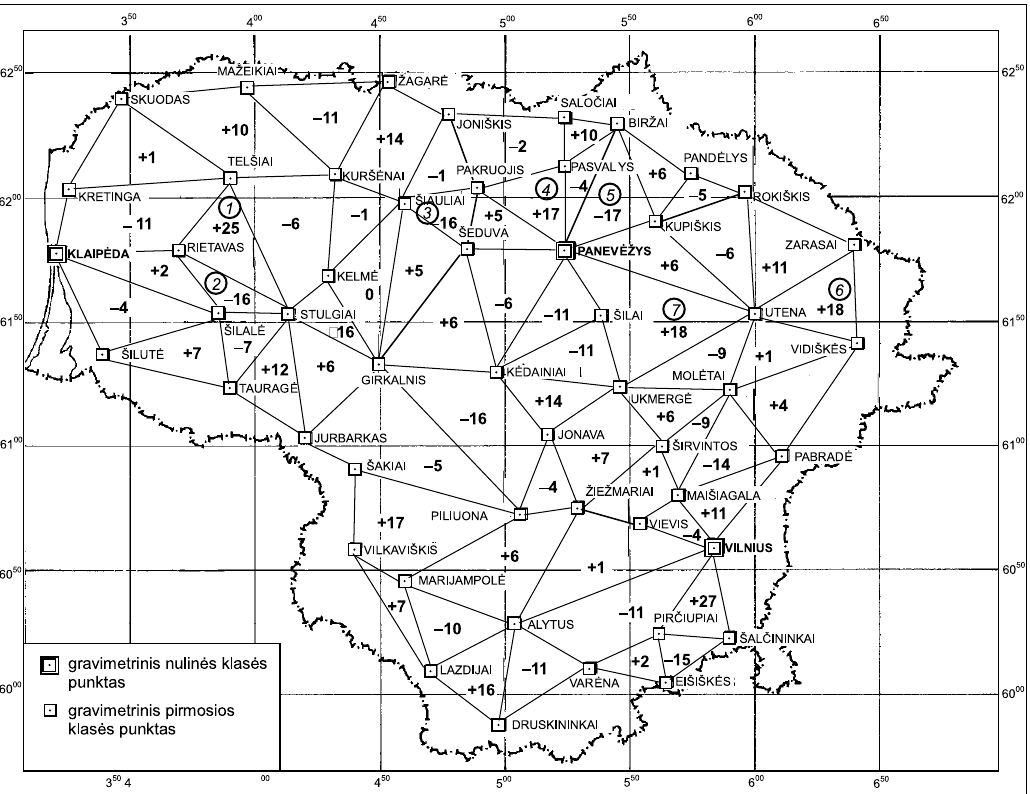
Fig. 1. Lithuanian National Gravimetric First Order Network and closing errors of polygons µGal